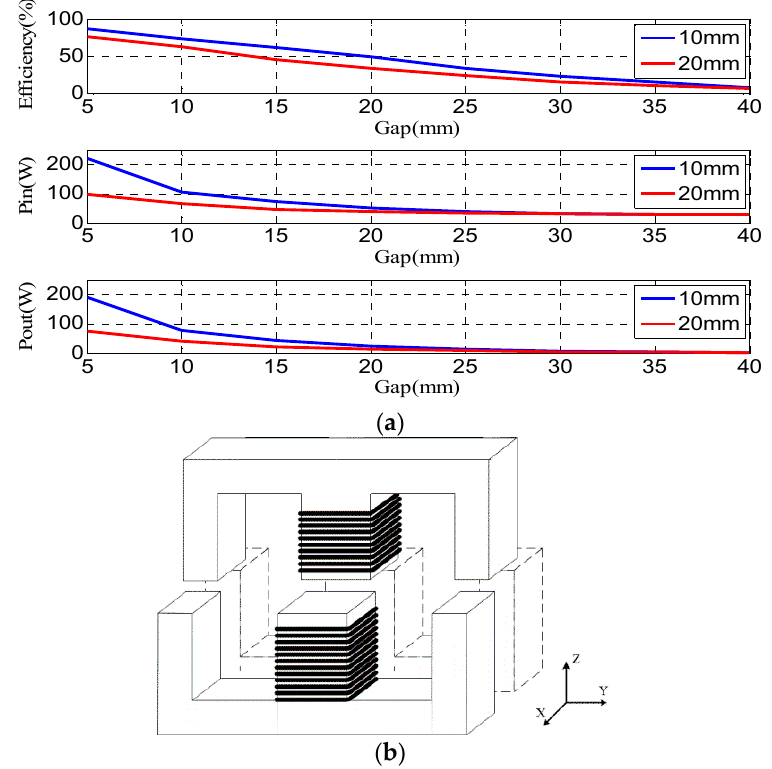
Figure 6. Displacement effect of the IPT system with varied air gap from 5 mm to 40 mm (V dc : 150 V; fsw: 20 kHz). ( a ) Efficiency, input power; and output power ( b ) Displacement. Table 4. Displacement effect of the IPT system with varied air gap from 5 mm to 40 mm (fsw: 20 kHz).